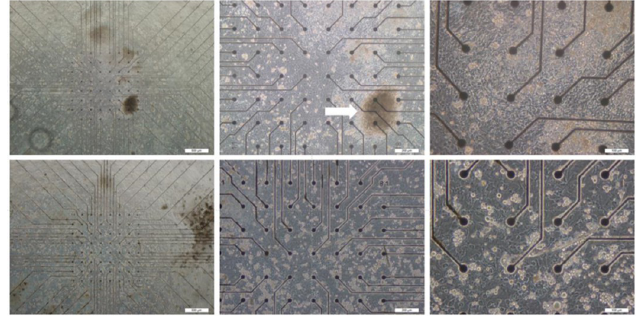
Fig 8. Cardiomyocyte cells cultured on a plate of multi-electrode